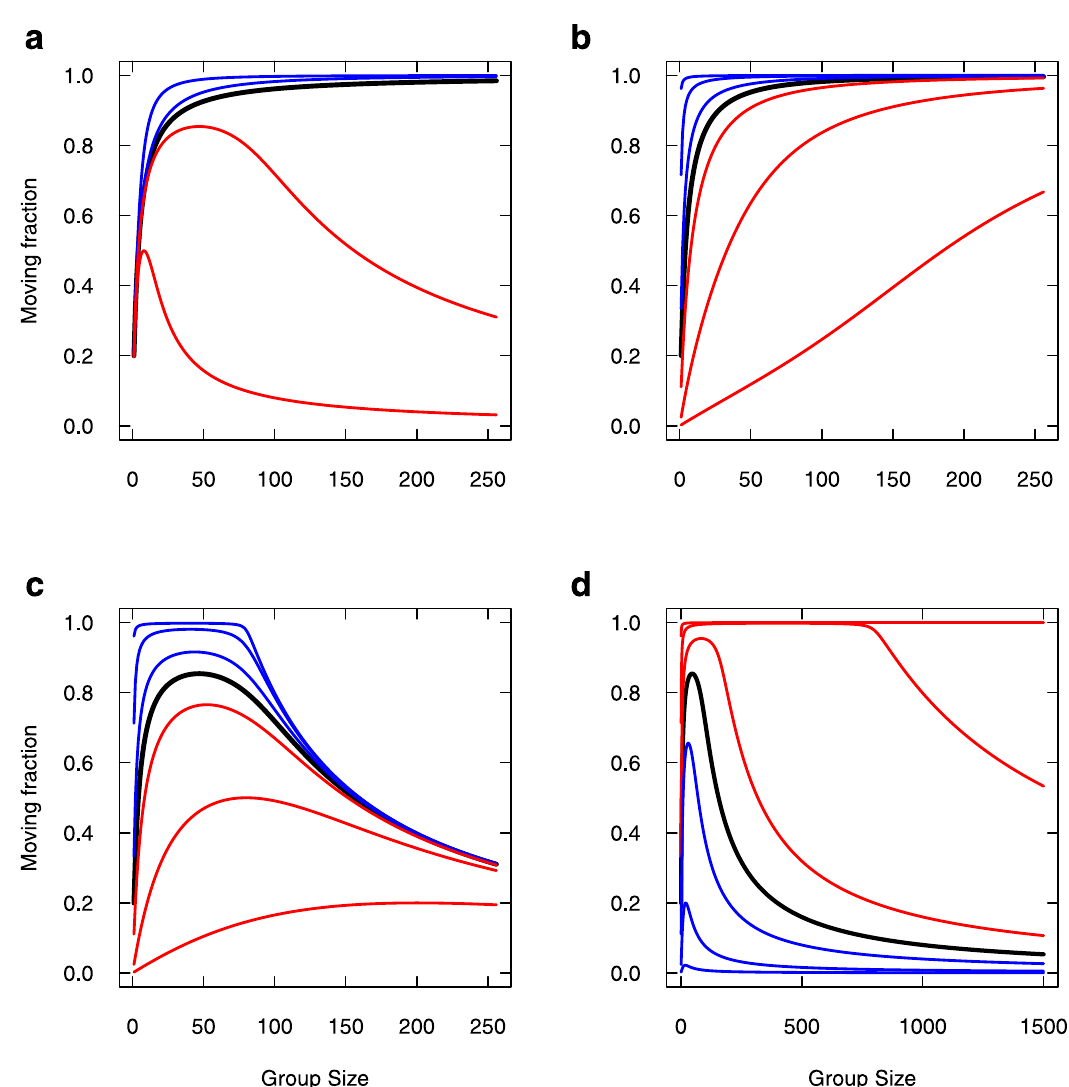
Fig 8. Moving fraction as a function of group size, varying individual parameters (Variant Model). Same legend as Fig 7 (same parameters, same parameter variations). Note the expanded scale in (d) to clearly show the effect; the upper red curve starts to decrease around N =